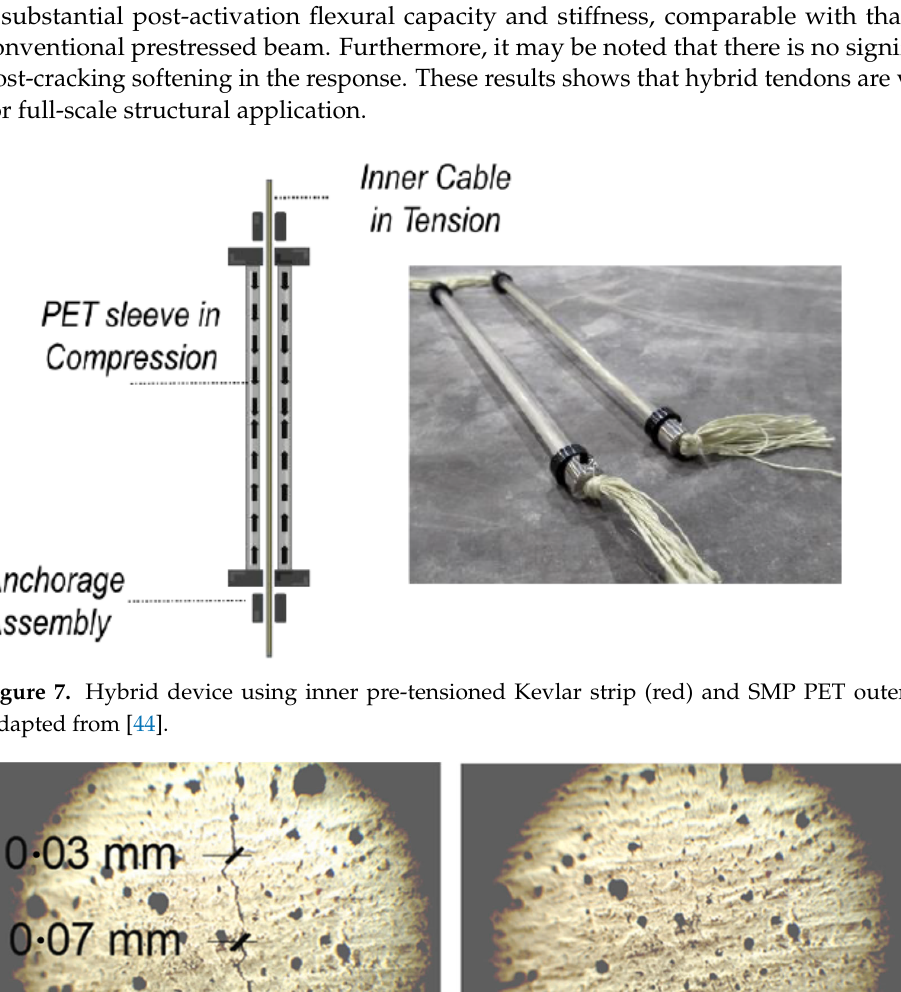
Figure 9. Load vs. CMOD response from flexural beam tests. Adapted from [44]. 3.4. SMP Knotted Fibre Composite Additional research considered PET knotted shape memory polymers (PET k ‐ SMP) in the form of filaments manufactured as described above in Section 2.2 [45]. This research benefits of adding mechanical anchorages to the ends of the fibres, providing additional reactional force when the k ‐ SMP fibres were heated in order to contract and close the crack. The mechanical anchorage was tested by means of a modified pull ‐ out test. Con ‐ crete blocks were prepared with both knotted or non ‐ knotted fibres and set up such that two concrete blocks were joined by a singular filament, with one block consequently ex ‐ periencing a force away from the other block. This caused the tendons without a knot to fail at levels between 10 N to 30 N—levels significantly lower than that of steel fibres but which are comparable to polypropylene (PP) and PET fibres. In contrast to these low re ‐ sistive forces, the k ‐ SMPs were able to withstand forces of 230 N to 290 N—loads which are comparable to the performance of steel fibres. When casting the specimens (using prismatic moulds) for crack closure, it was de ‐ cided that two distributions of sample would be made—those with an aligned distribution (AD) where 30 fibres were specifically placed in the bottom half of the specimen where most cracking was expected to occur, and the other sample contained fibres in a random distribution (RD) across the specimen, adding the fibres during the mixing process. The